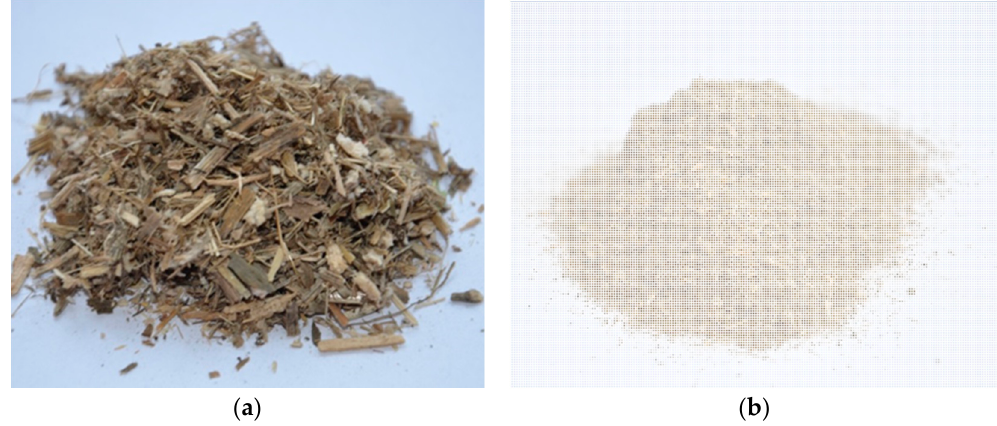
Figure 1. Raw ( a ) and extruded ( b ) corn straw used in the experiment.